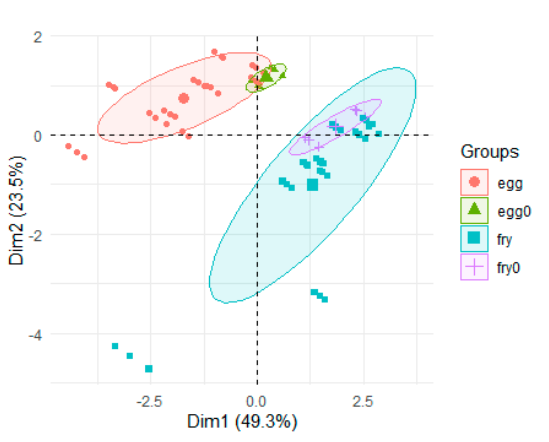
Figure 1. Principal component analysis (PCA) by groups according to life stage (eggs, fry) of the rainbow trout, chemical compound (AgNPs, AgNO 3 ), and Ag concentration (0, 1, 2, 4, 8, 16 mg/L). Dim—dimension.